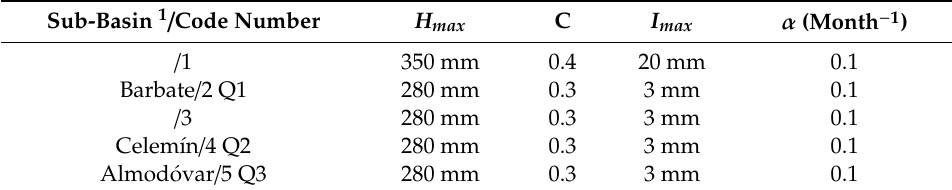
Figure 5. Flow hydrographs of calculated and observed contributions for the period 2000–2015. Table 2. Parameters after T-RRM